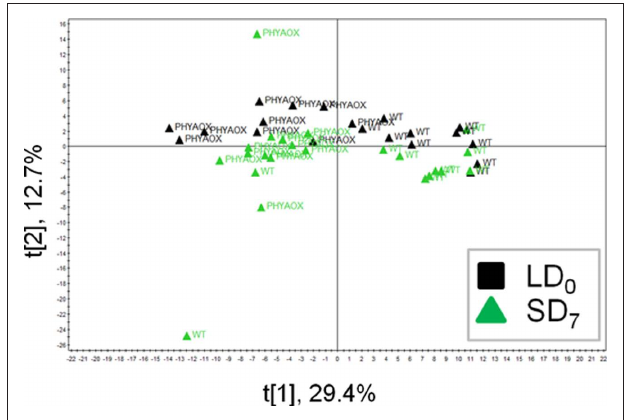
; green triangle, SD . Abbreviations: 0 7